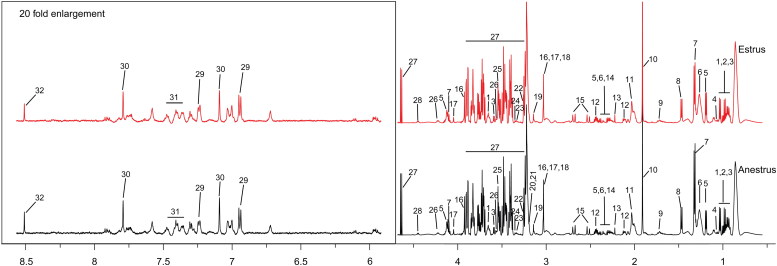
Typical 600 MHz 1H NMR spectra of plasma from estrus group and anestrus group. Metabolites: (1) Isoleucine; (2) Leucine; (3) Valine; (4) 3-Hydroxyisobutyrate; (5) 3-Hydroxybutyrate; (6) 3-Hydroxyisovalerate; (7) Lactate; (8) Alanine; (9) Arginine; (10) Acetate; (11) N-Acetylglycine; (12) Glutamine; (13) Levulinate; (14) Pyruvate; (15) Citrate; (16) Creatine; (17) Creatinine; (18) Creatine phosphate; (19) Dimethyl sulfone; (20) Choline; (21) Phosphatecholine; (22) Betaine; (23) Methanol; (24) Theophylline; (25) Glycine; (26) Threonine; (27) Glucose; (28) Lactose; (29) Tyramine; (30) Histidine; (31) Phenylalanine; (32) Formate.